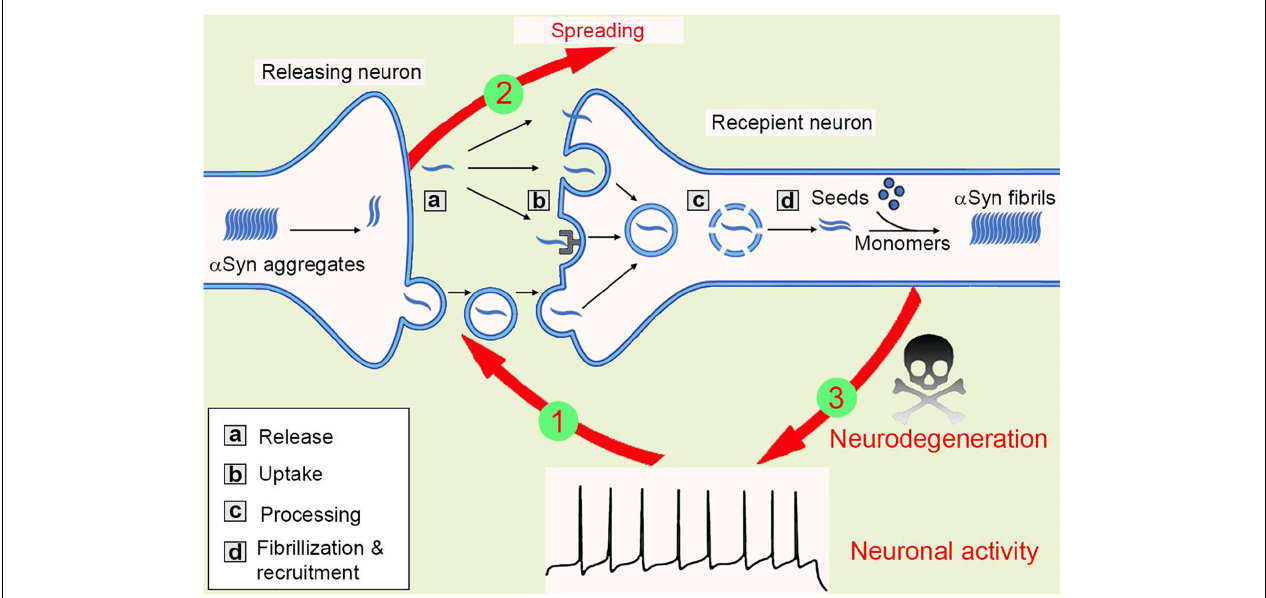
FIGURE 2 | The spreading of α Syn aggregates between neurons. Mutations or neurotoxic environmental factors initialize the α Syn aggregation in the releasing neuron. The aggregates are released into extracellular via vesicle/exosome, and neuronal activity facilitates or inhibits this process (1). Then, the aggregates are taken up by macropinocytosis, LAG-3 receptor, or penetration into cell membrane directly. The aggregates transport inside the recipient cells, most of them will be degraded in lysosome, but some lysosomes will be ruptured and release aggregates, that are working as “seeds” to recruit endogenous α Syn monomers into new fibrils. Thus, the amyloidogenic aggregates spread between cells (2). The α Syn aggregates then compromise synaptic activity, inhibit spine formation, and finally result in neurodegeneration